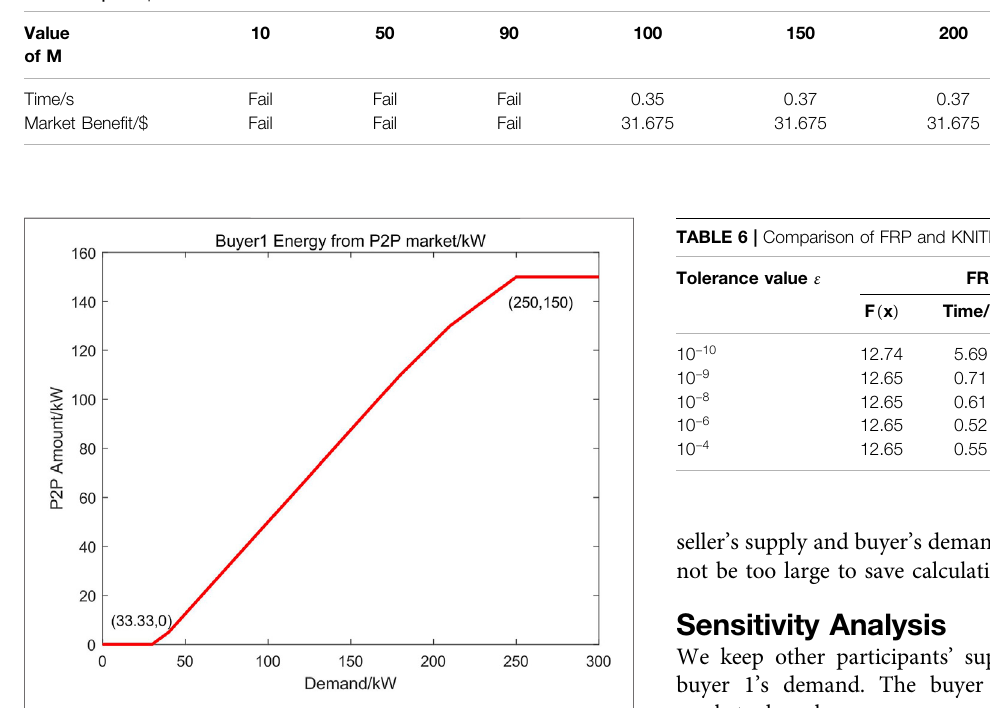
TABLE 5 | Comparison of different value of M.